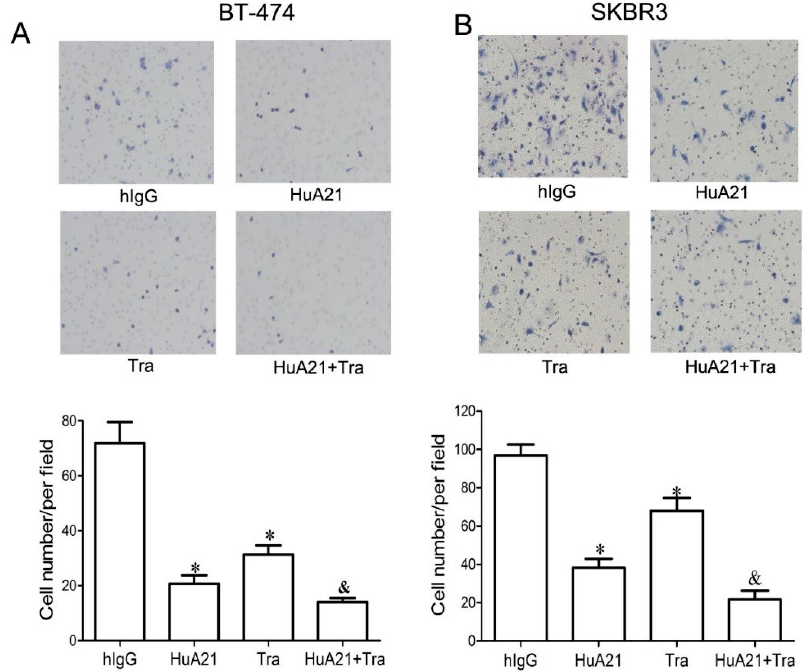
Figure 3. HuA21 suppressed the migration of breast cancer cells. The representative images and bar graph indicate the inhibitory effects of HuA21 (10 µg/mL), trastuzumab (Tra, 10 µg/mL), or HuA21 (10 µg/mL) + Tra (10 µg/mL) on the migration of BT-474 ( A ) and SKBR3 ( B ) breast cancer cells. The cells were treated with HuA21, Tra, or HuA21 + Tra for 24 h. Magnification: 100×. * p < 0.05 vs. control; & p < 0.05 vs. HuA21-treated cells. The experiments were performed in triplicate, and the data are representative of three separate